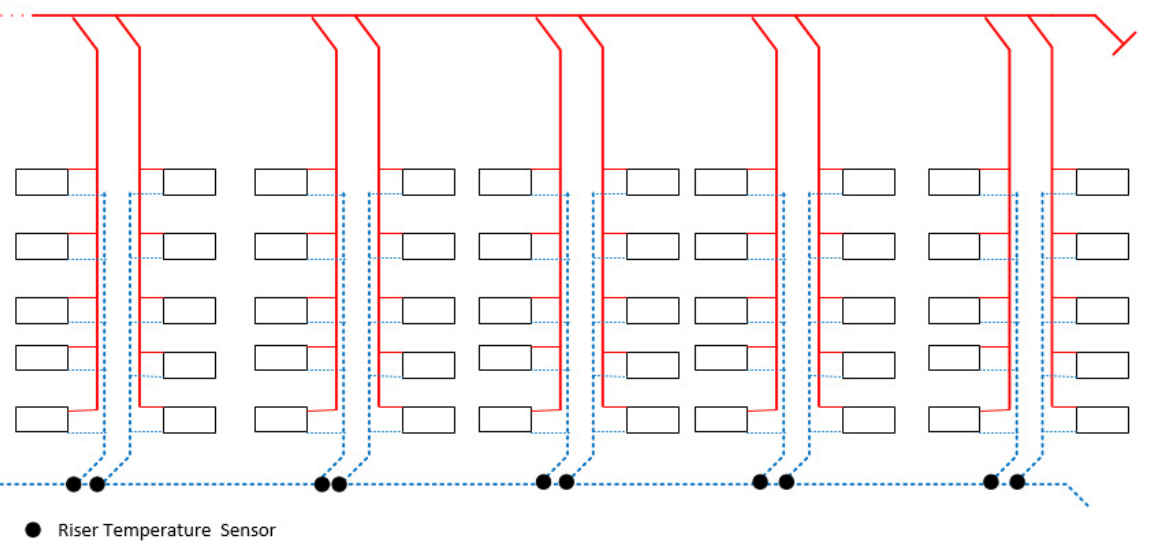
Figure 4. Building B section of the pipelines, risers and radiators; temperature sensors are installed on each return riser.